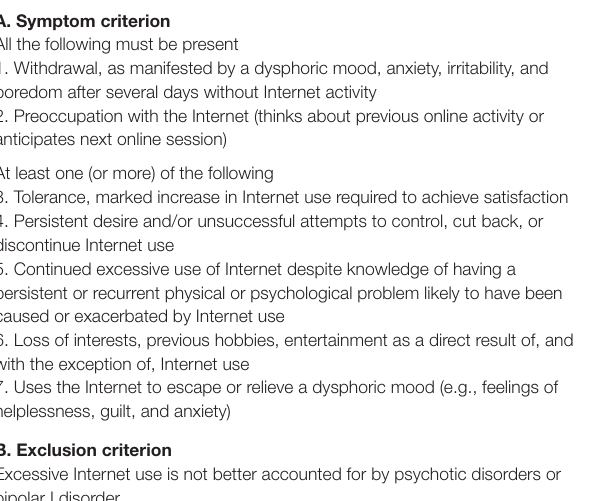
taBLe 1 | internet addiction diagnostic criteria